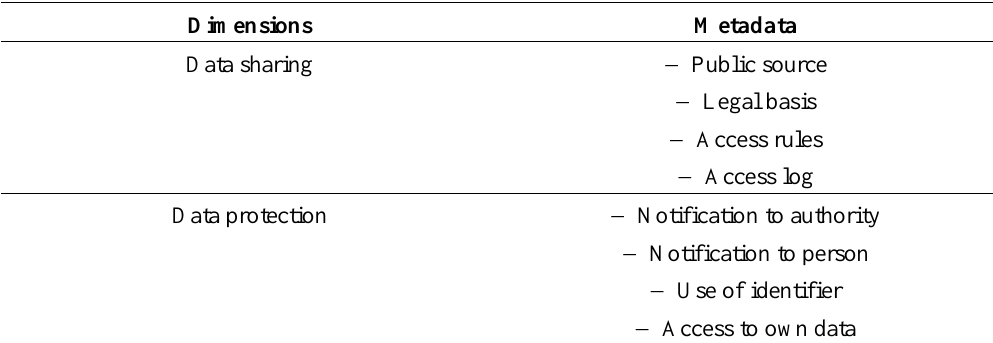
Table 1. Description of data sharing and data protection dimensions.